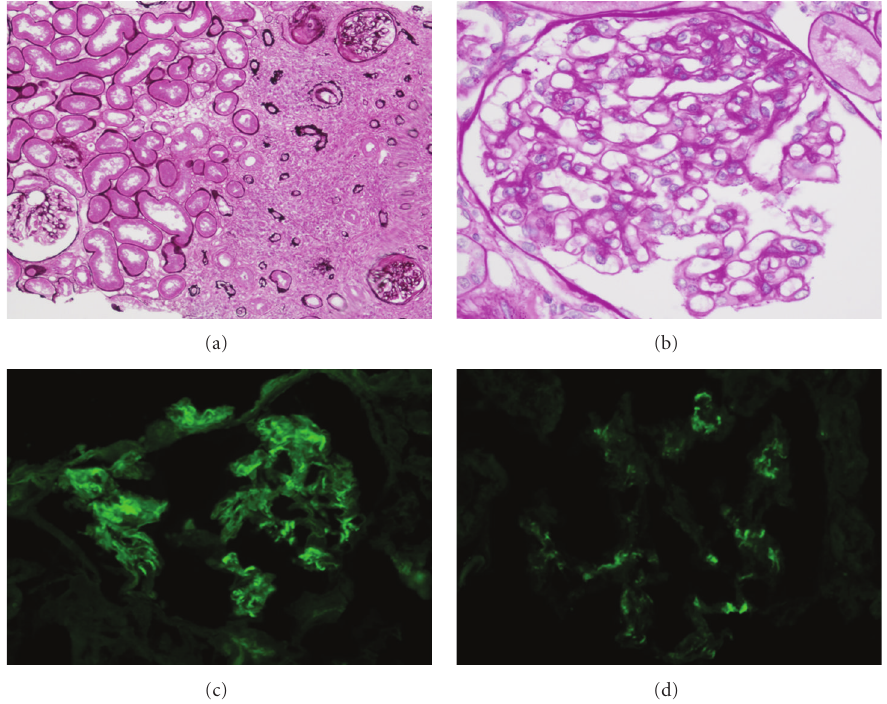
Figure 3: IgG4-related tubulointerstitial nephritis with IgA nephropathy. (a) Periodic acid-Schi ff (PAS) staining reveals severe tubu- lointerstitial nephritis (PAS x100). Regional lesion distribution is evident. (b) Segmental mesangial proliferation is seen (PAS × 400). (c) Immunofluorescence staining for IgA reveals bright mesangial deposits ( × 400). (d) Immunofluorescence staining for C3 reveals weak mesangial staining for C3 ( × 400).